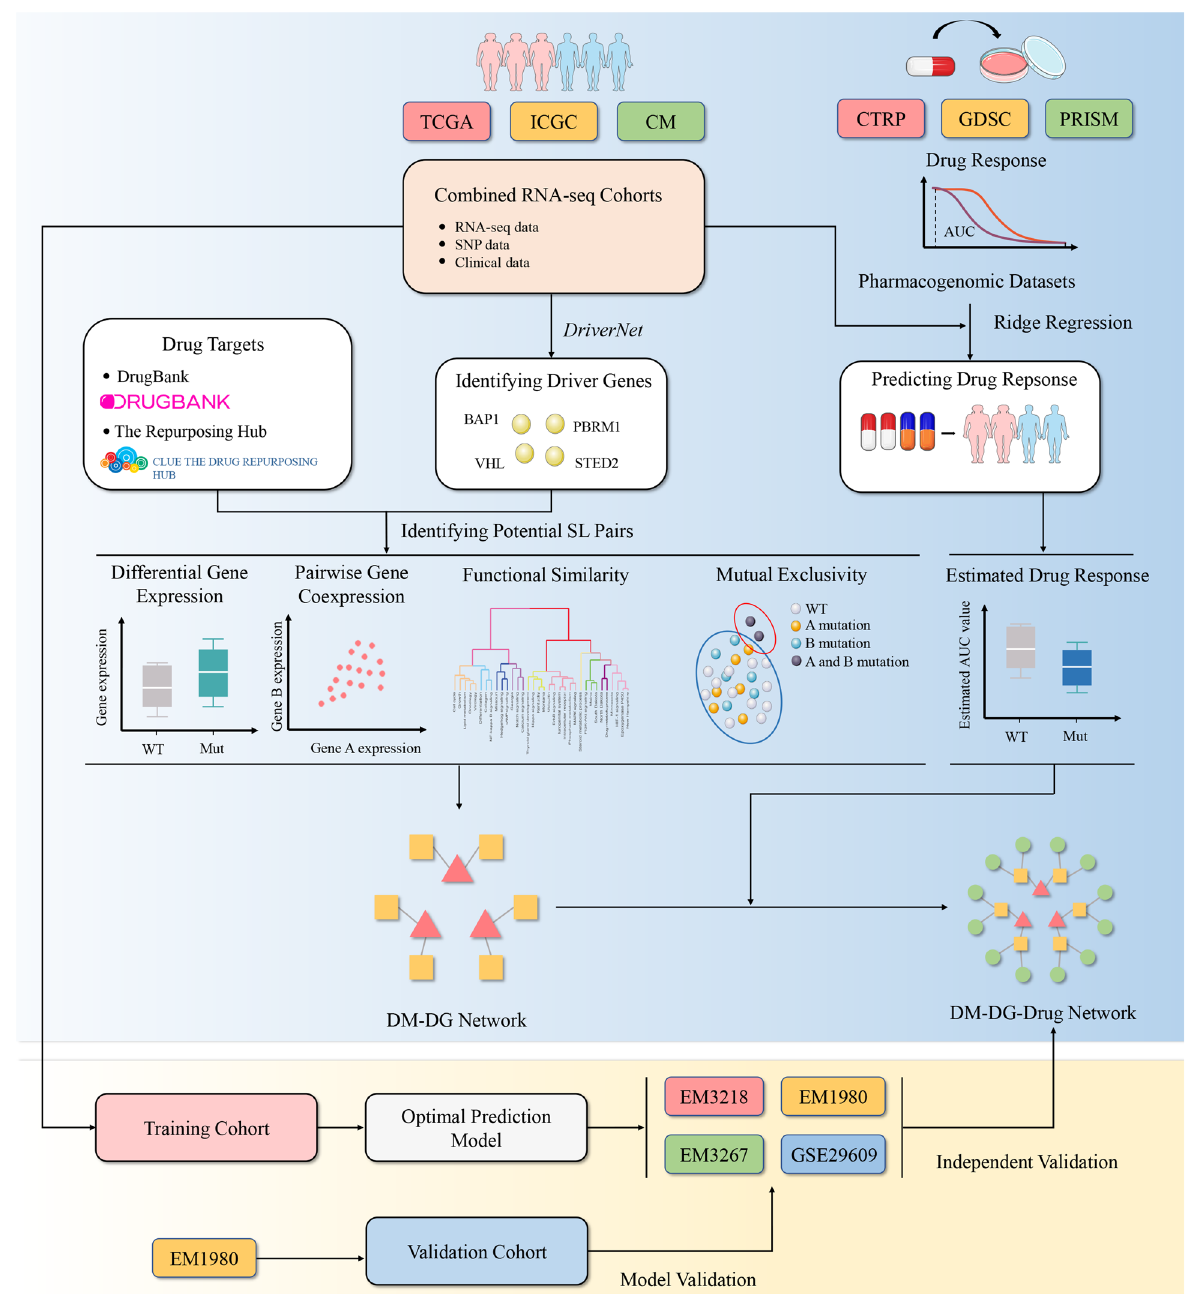
Figure 1. Flow chart of identification of potential synthetic lethal interactions and construction of DM-DG- drug